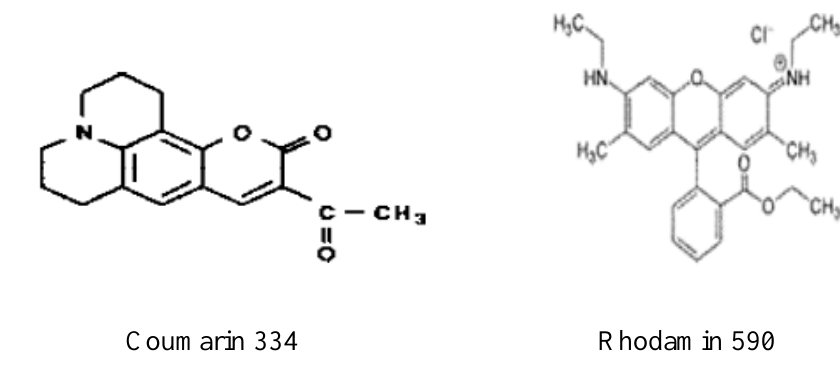
Fig. 2: Sitructures of the examined dyes.